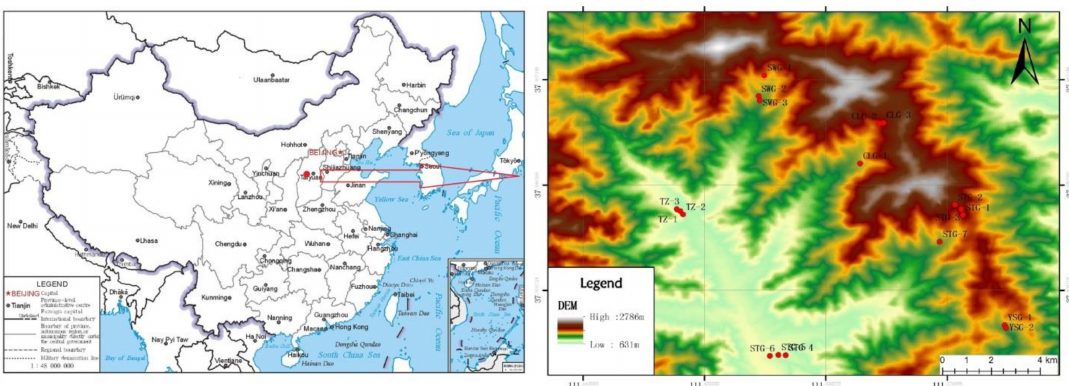
Figure 1. Study area and sampling sites along the altitudinal gradients of Guandishan Mountain, China.